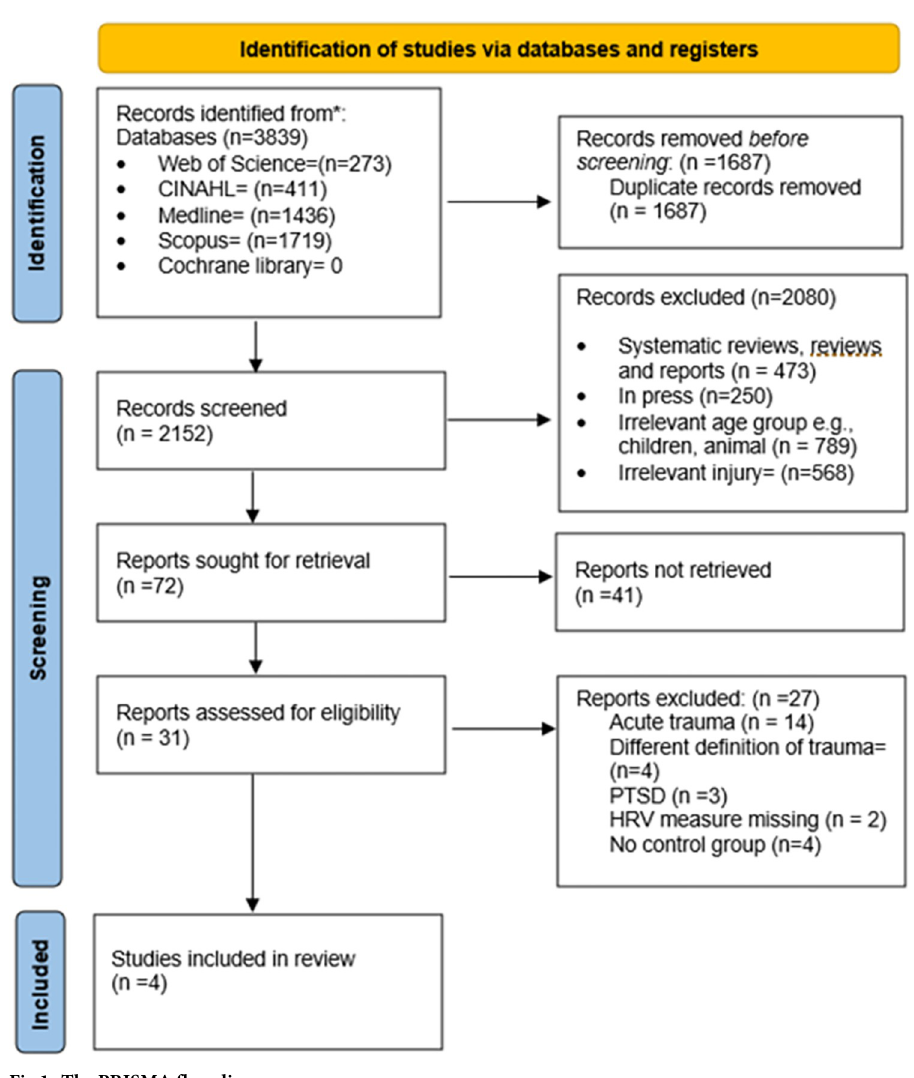
Fig 1. The PRISMA flow